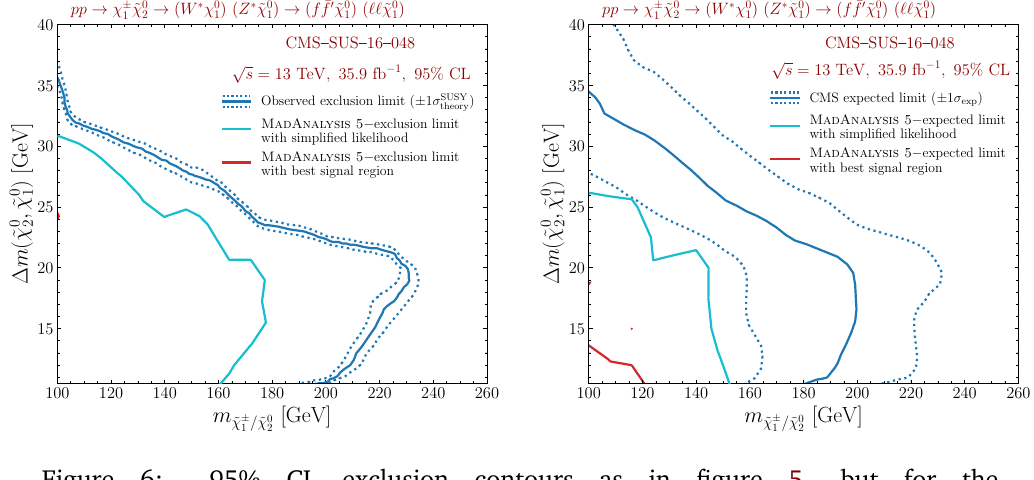
Figure 6: 95% CL exclusion contours as in figure 5, but for